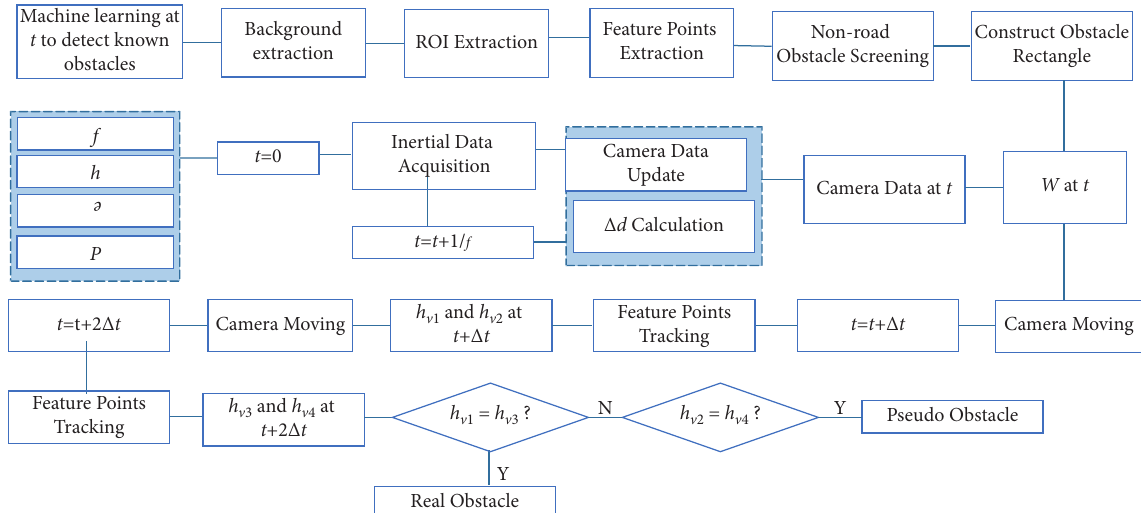
Figure 15: Improved VM pseudo-obstacle identification flowchart.